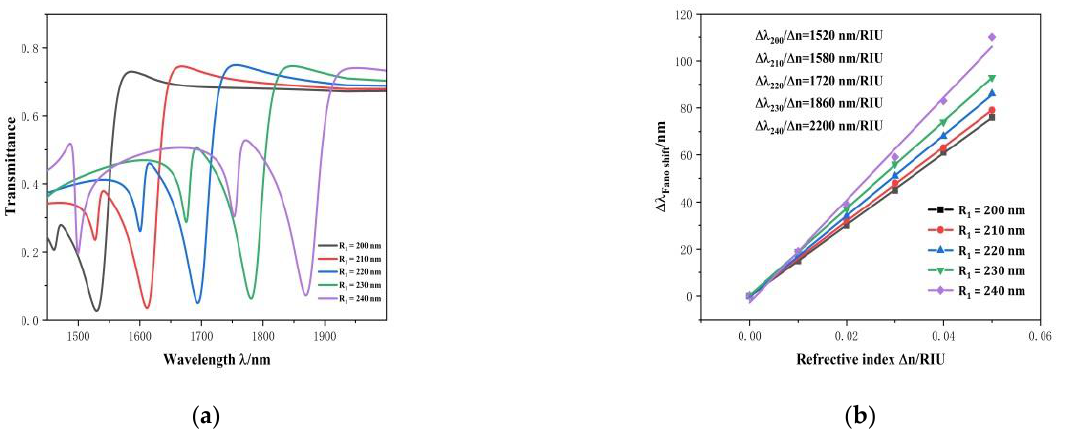
Figure 5. ( a ) Transmission spectrum of the outer ring of CCDRR for different external radii R 1 ; ( b ) shifts of the dip point in Fano resonance ( Δλ ) with a changed refractive-index ( Δn ). Fano resonance ( ∆ λ ) with a changed refractive-index ( ∆ n